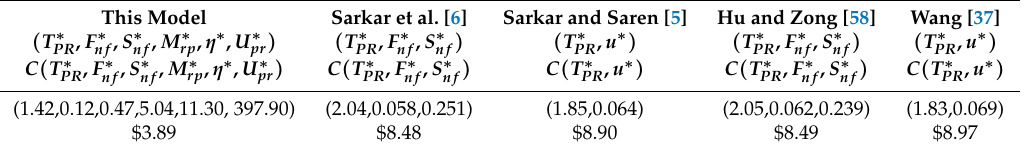
Table 5. Total cost comparison table with existing